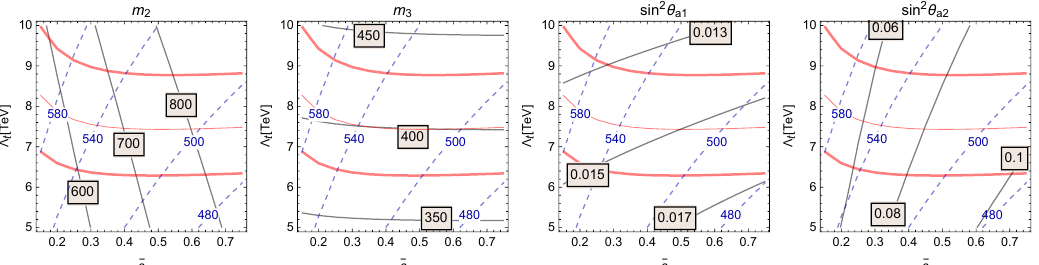
Figure 6 . From left to right: the mass m 2 of the approximate radial mode of SU(4) (cid:27) SU(2) a ; the mass m 3 of the scalar associated with the other SU(4); the mixing angle sin 2 (cid:18) a 1 between the SM doublet h a and the radial mode of SU(8); and the mixing angle sin 2 (cid:18) a 2 between the SM doublet h a and the approximate radial mode of SU(4) (cid:27) SU(2) a . In each frame, the red band denotes the Higgs mass window (122 GeV, 128 GeV), while the dashed line indicates the scale of f in unit of GeV. The numerical values used in this plot are those reported in table 1 for (cid:15) (cid:0)